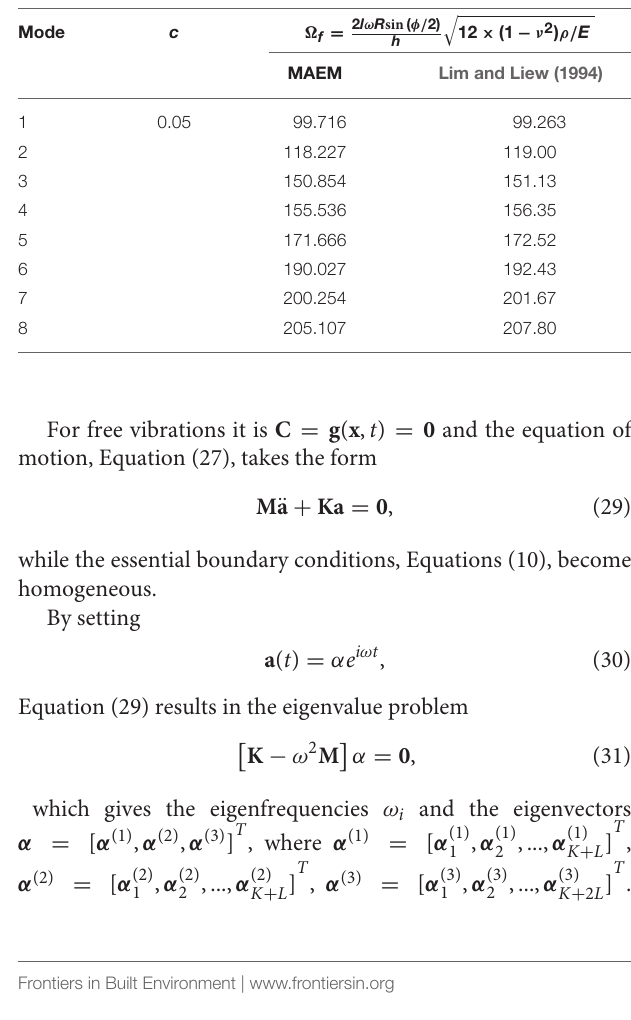
TABLE 3 | Eigenfrequency parameters of the shell in Example 3: case (a).